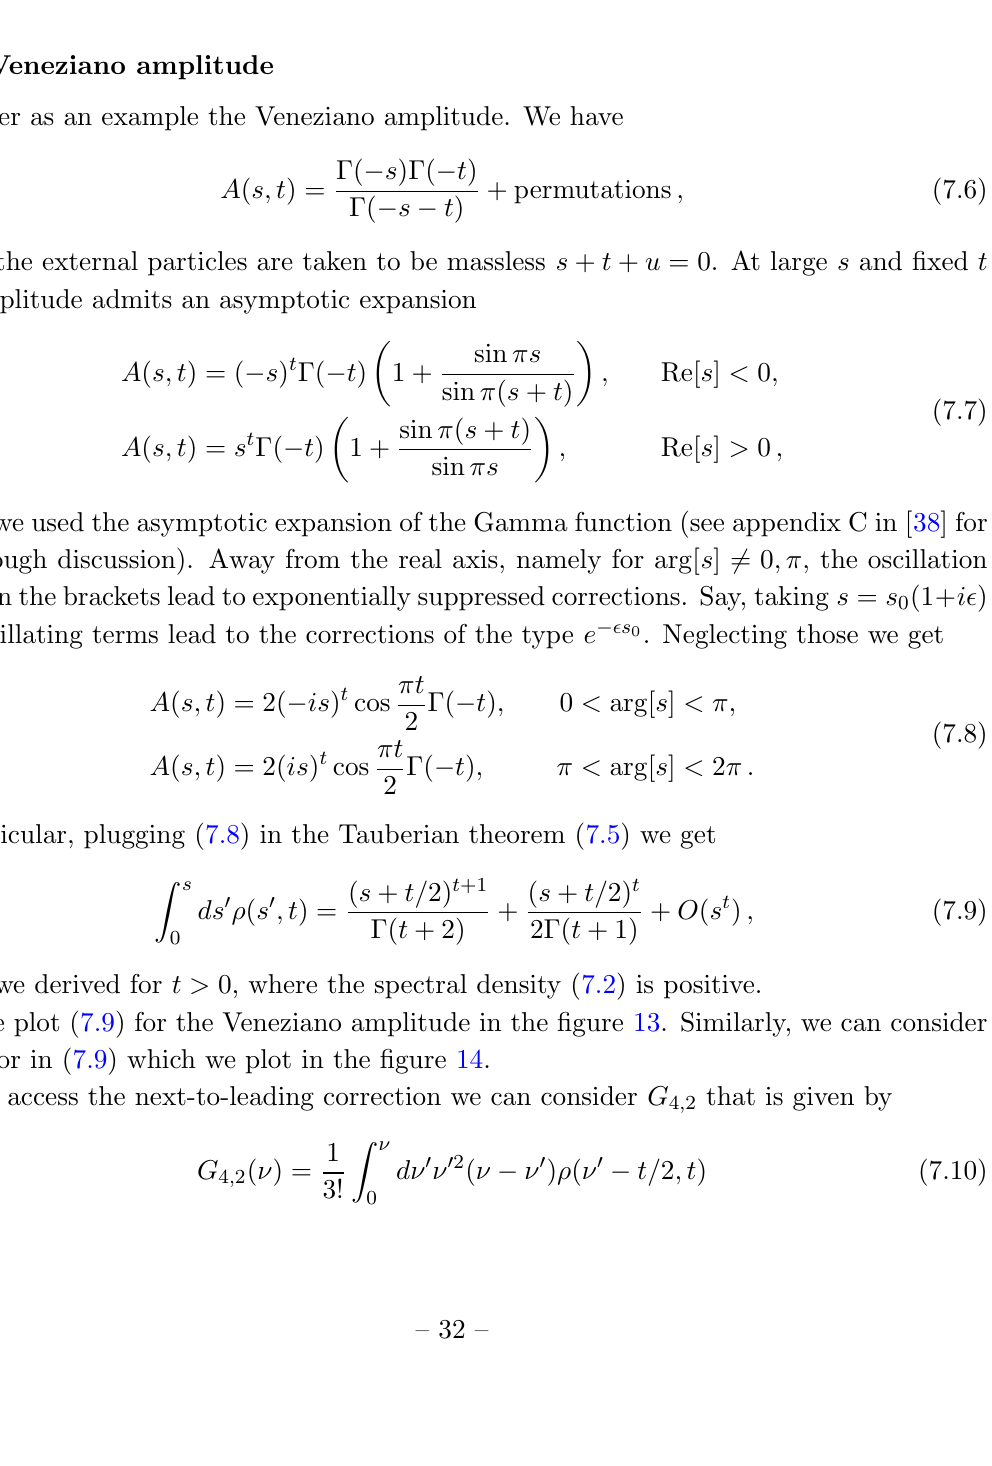
Figure 13 . Integrated spectral density for the Veneziano amplitude (7.9). We plot (7.9) for t = 1 :